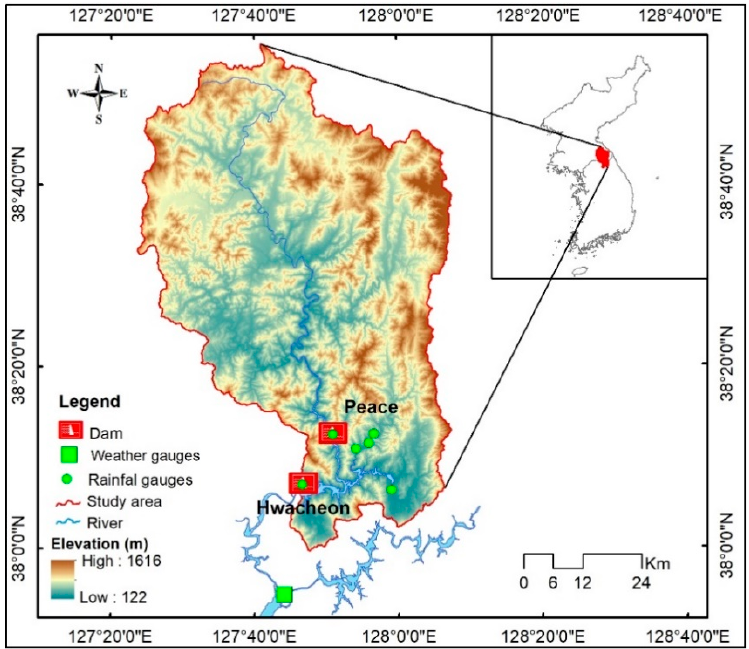
Figure 3. Geological location and topographic characteristics of the ‘Hwacheon’ dam watershed located in the central part of the Korean Peninsula.